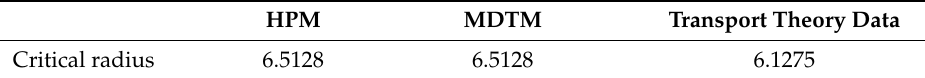
Table 5. Critical radius of one-group reflected reactor.